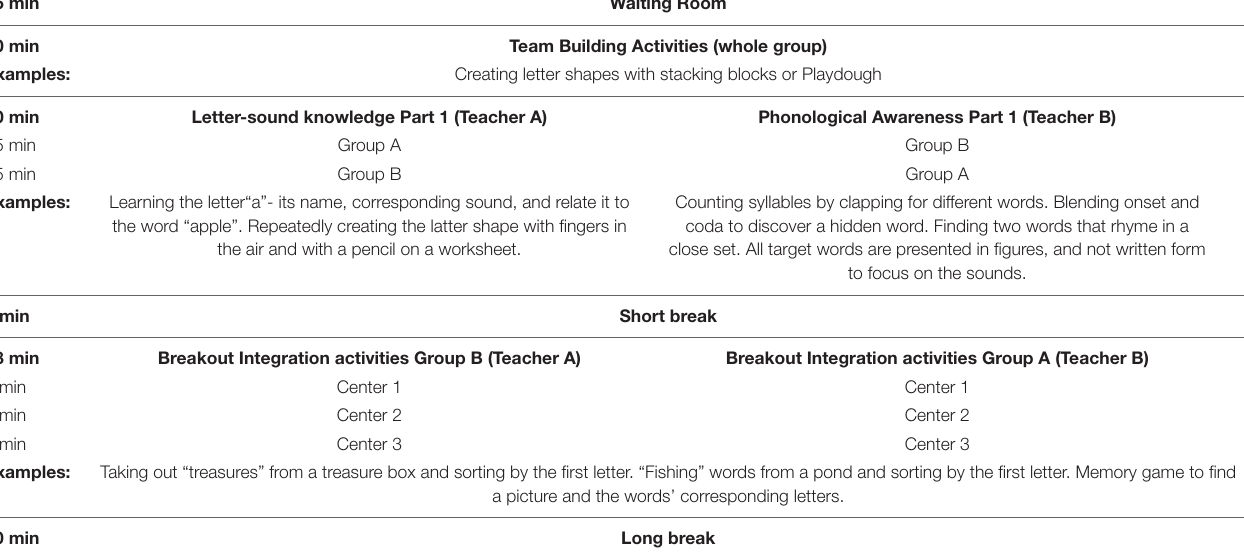
TABLE 2 | Online reading camp daily schedule with